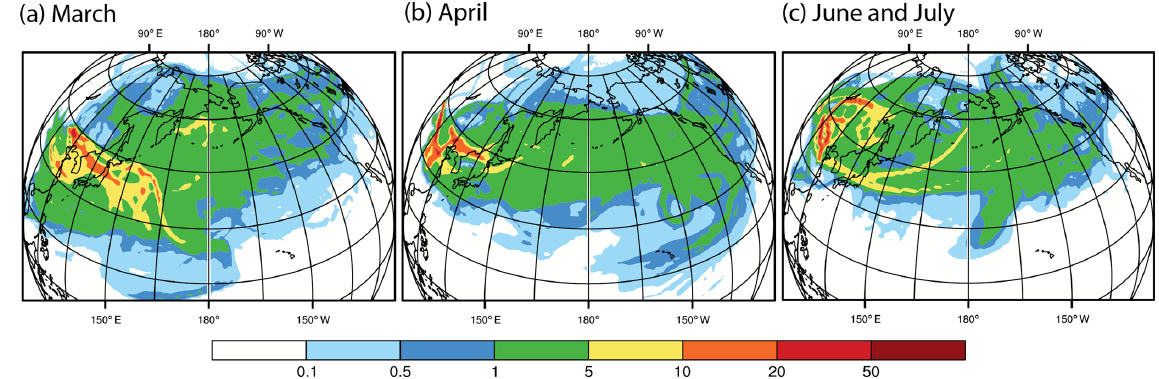
Figure 9. Trajectory passage frequency (% of trajectories) from the central Gobi Desert in (a) March, (b) April, and (c) June and July during 2001–2003. There are at least 2500 data points with initial injection height exceeding 2kma.m.s.l. in each of the analyzed periods. The trajectory passage frequency is calculated as the number of trajectories crossing over each 1 ◦ latitude × 1 ◦ longitude grid in the Northern Hemisphere divided by the total number of trajectories from the Gobi Desert in each month.